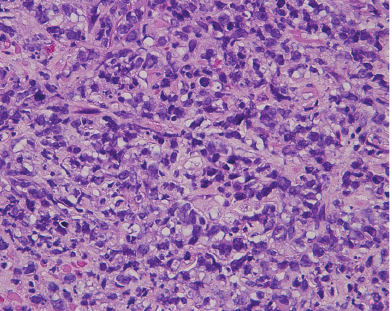
Figure 3: A histological section showing a diffuse large B cell lymphoma (H&E).